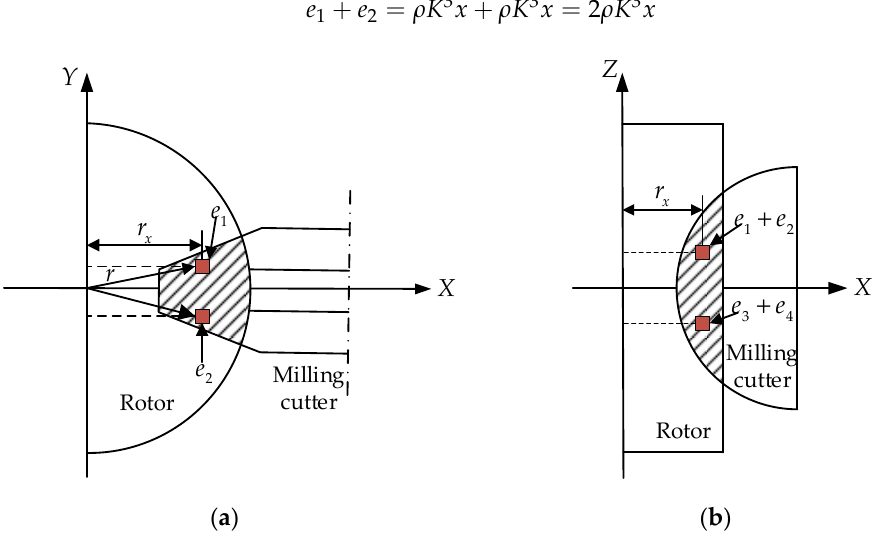
Figure 4. Discrete model of V-shaped milling: ( a ) milling section on X–Y plane; ( b ) milling section on X–Z plane.